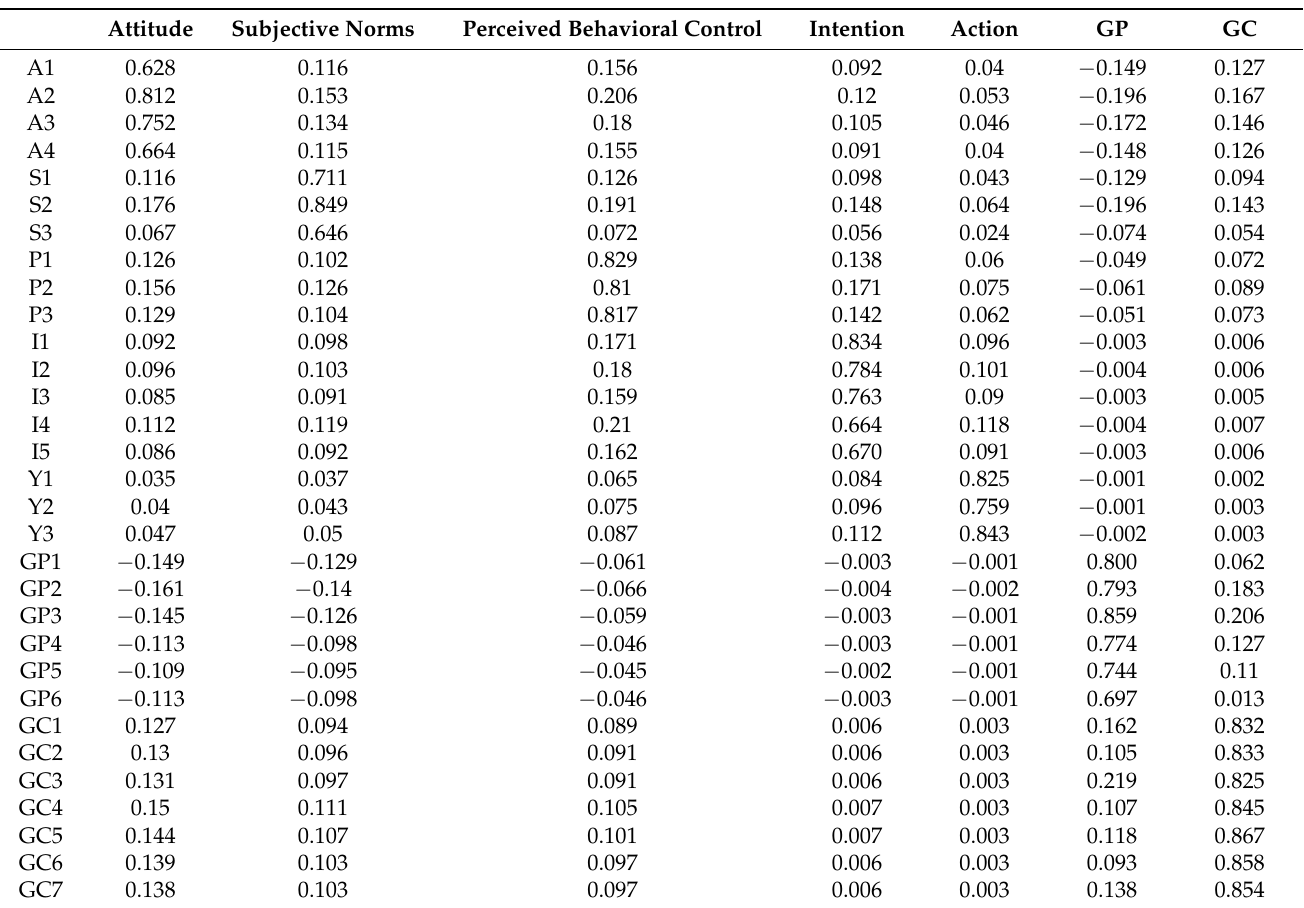
Table A2. Discriminant validity (intercorrelations) of variable